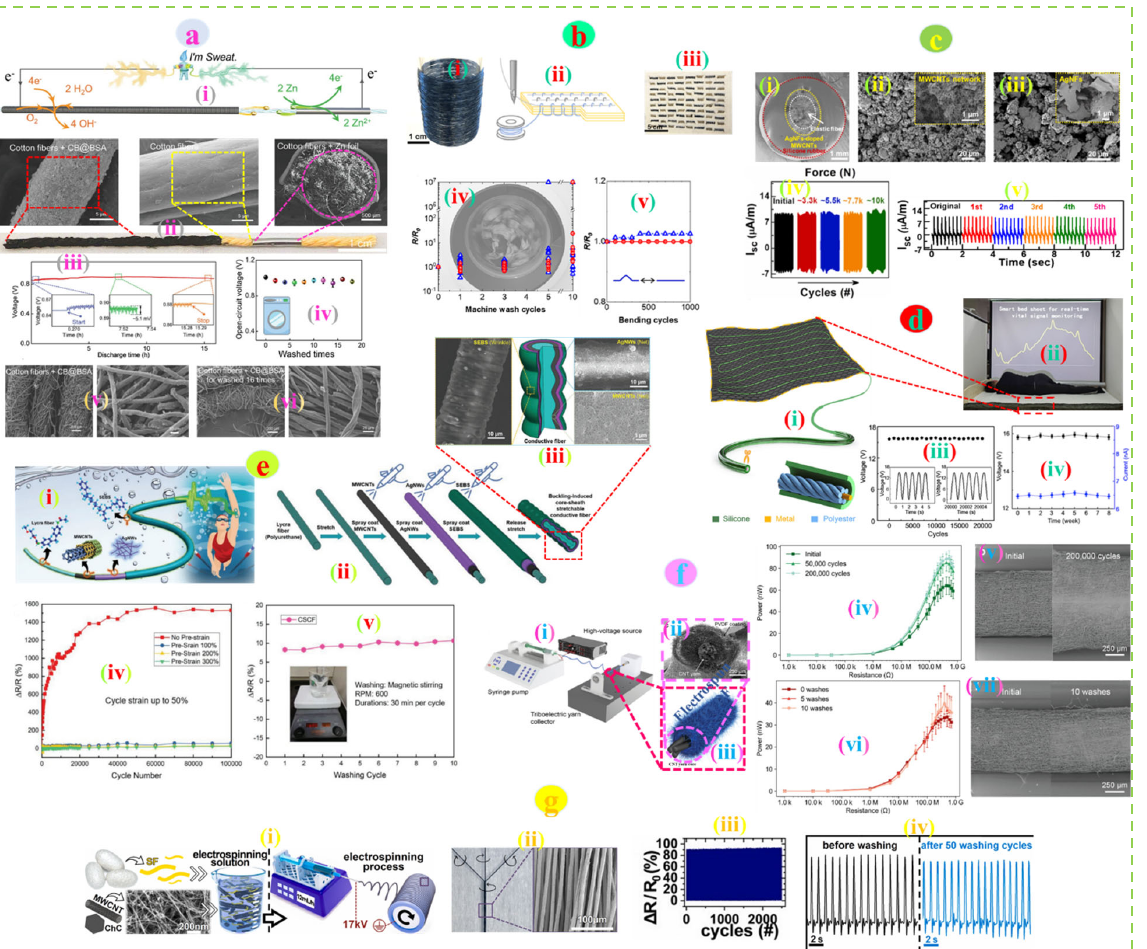
Figure 4. ( a ) (i) Schematic of the working principle of yarn ‐ based sweat ‐ activated battery, (ii) optical image of the substrate along with surface morphologies of different sections, (iii,iv) durability against cyclic operations and repeated washing cycles, (v,vi) surface morphology before and after 16 washing cycles. Reproduced with permission [156] Copyright 2022, Wiley. ( b ) (i) Roll (70 m) of conductive cellulose yarn, Schematic of the machine ‐ sewn stitches (ii), and thermoelectric generator with 40 out ‐ of ‐ plane thermocouples (iii), (iv) resistance change after 10 machine washing and (v) 1000 bending cycles. Reproduced with permission [157] Copyright 2020, American Chemical Society. ( c ) (i) MWCNTs ‐ coated and AgNFs ‐ doped ‐ MWCNTs ‐ coated fiber, and (iv,v) Current output (ISC) under